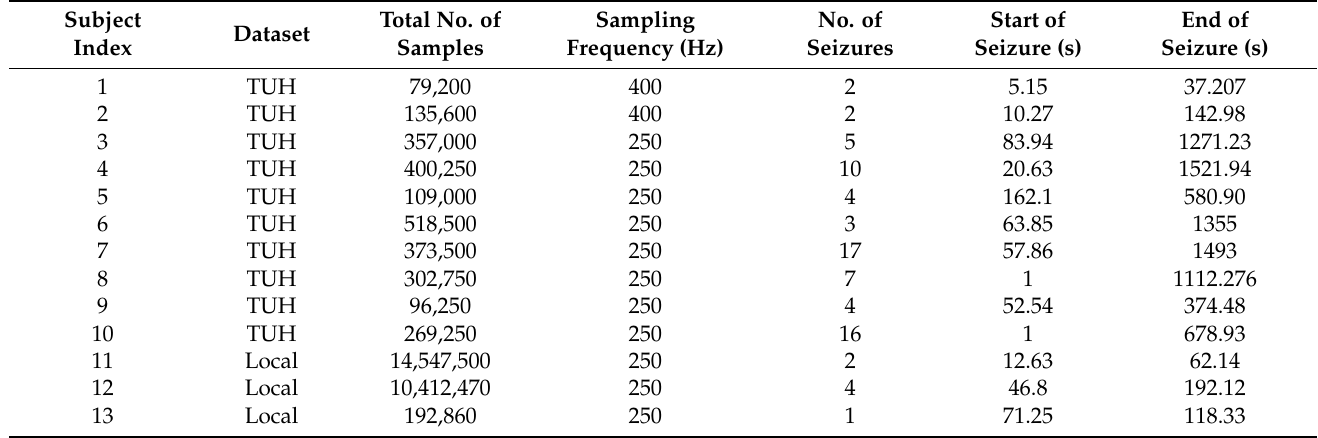
Table 1. Segment wise Dataset